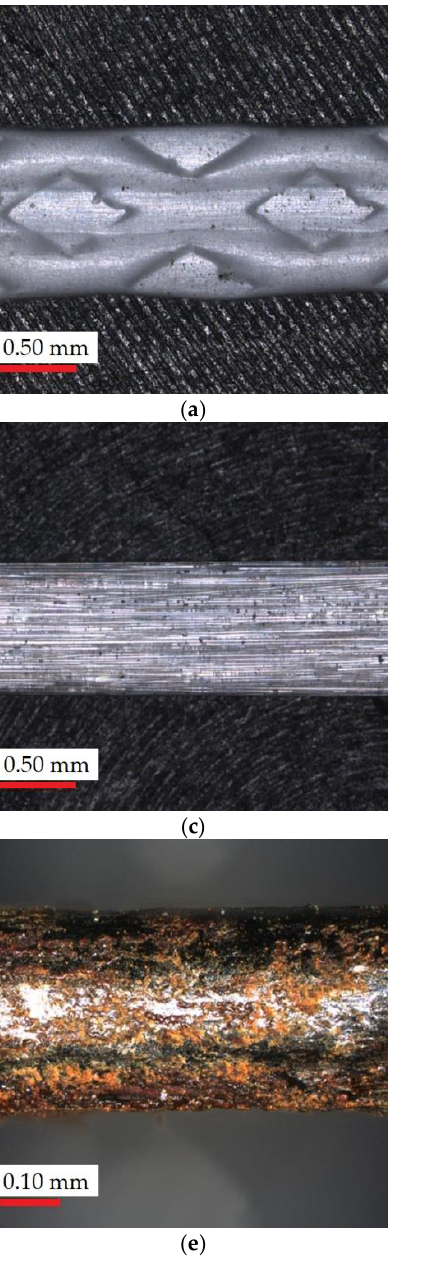
Figure 4. Light microscopy images: ( a ) polypropylene fiber surface; ( b ) polypropylene fiber cross- section; ( c ) glass fiber surface; ( d ) glass fiber cross-section; ( e ) steel fiber surface; ( f ) steel fiber cross- section.